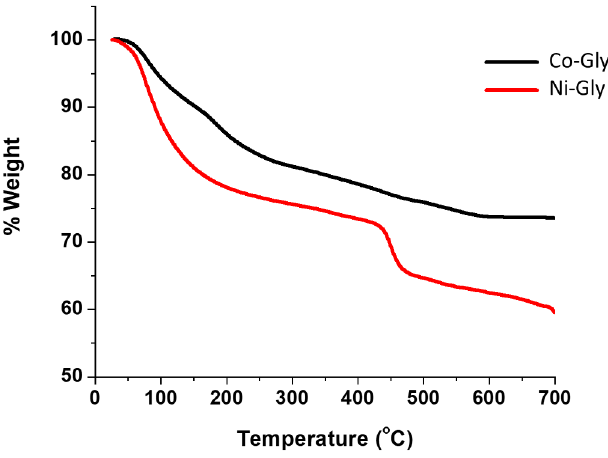
Figure 2. Thermal behaviour of Co–Gly and Ni–Gly.